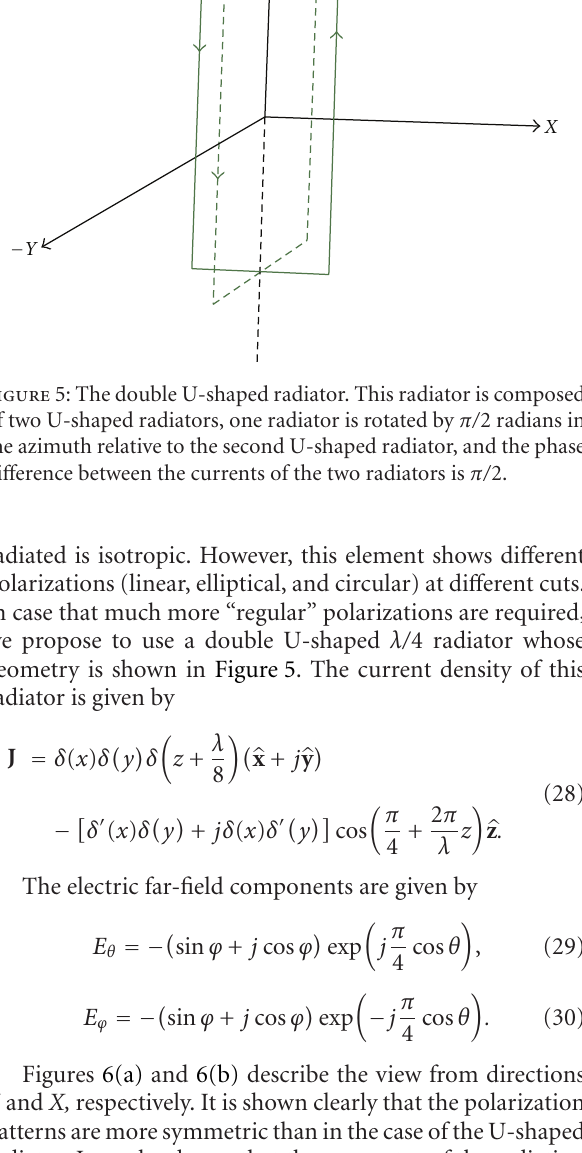
Figure 6: (a) Schematic view of an observer, of the far-field polarization of the double U-shaped power isotropic radiator at the angles θ = 0, π/ 4, π/ 2, and at multiples of π/ 8 of the angle ϕ. The observer looks into the direction of the negative Z -axis. The polarizations have been drawn by rotating them so that they appear perpendicular to the line of sight. The green drawing represents the direction of the current of the radiator at a given time. The red ellipses represent the electric field, while the blue ellipses the magnetic field. The tip of the arrow (in black) indicates the phase for a given time, and the arrow points in the direction of the rotation of the fields. (b) Similarly as in Figure 6(a), but here the observer looks into the direction of the Y -axis, and the polarizations are drawn for θ = 0, π/ 4, π/ 2,3 π/ 4, π and ϕ = 0, ± π /8, ± π /4, ± 3 π